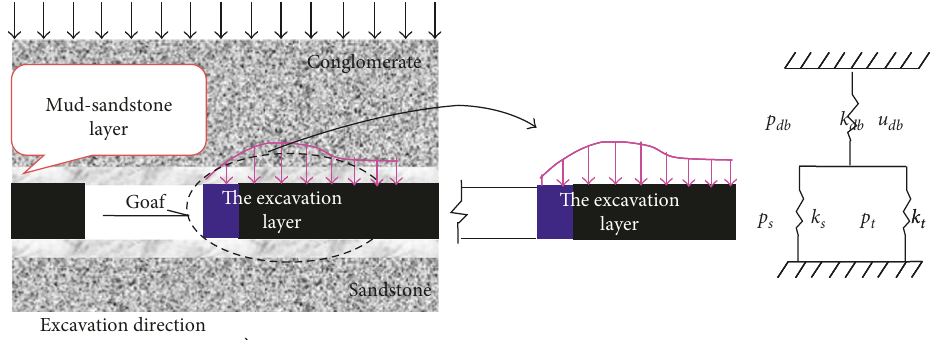
Figure 1: Simplified mechanical model for the analysis of underground